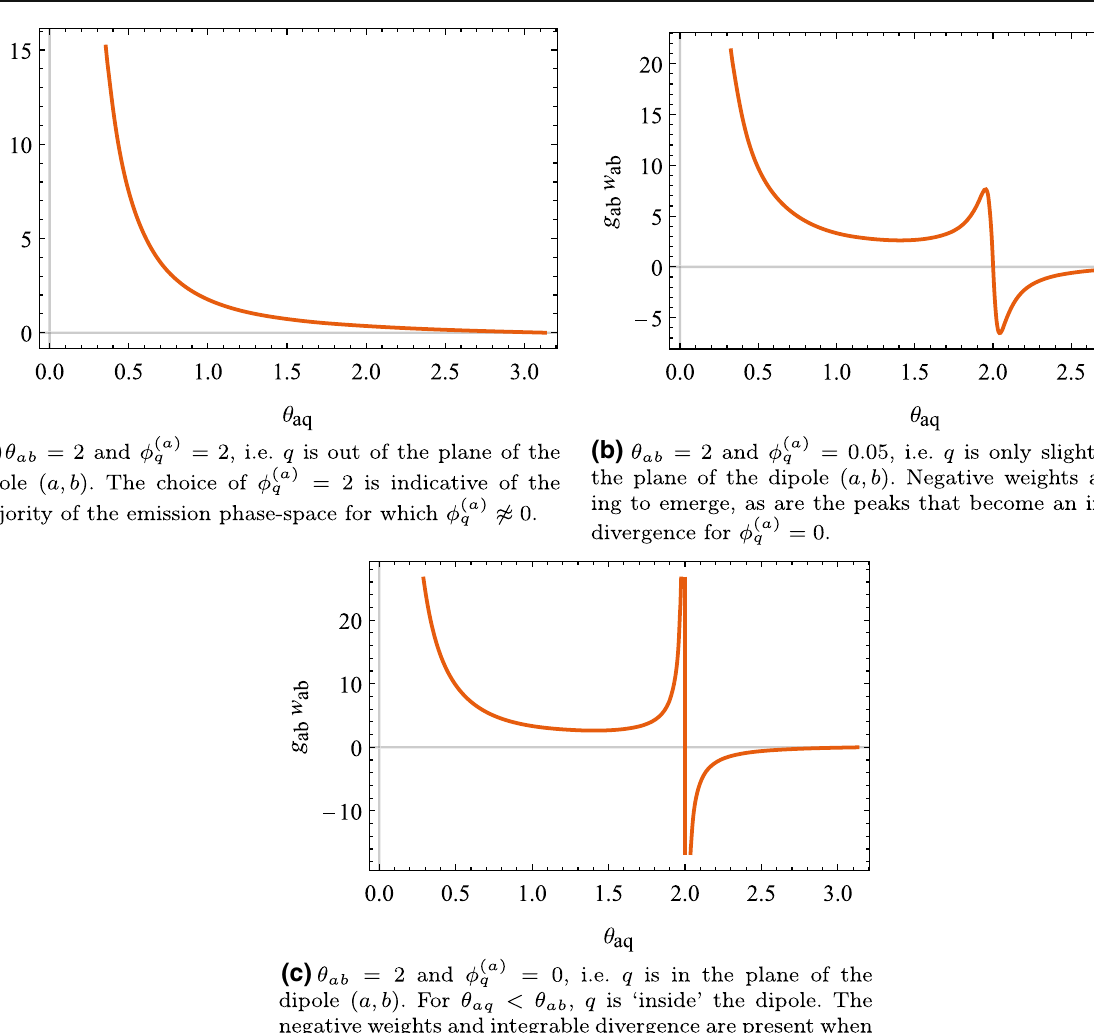
Fig. 9 Graphs of g ab w ab as a function of θ ab ,θ aq ,φ ( a ) q as measured in the lab